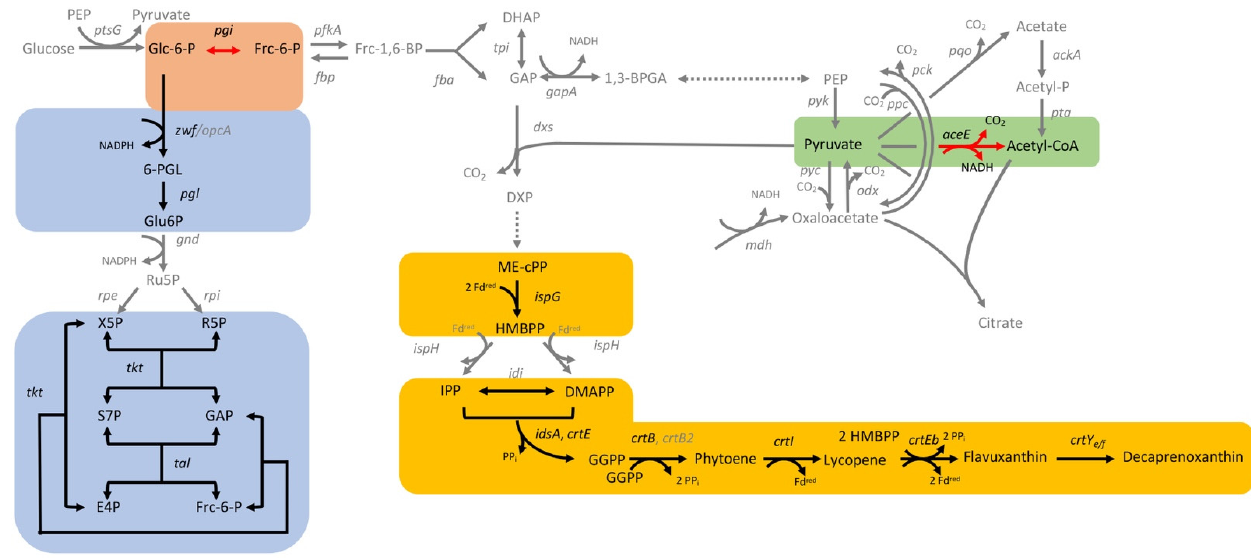
Figure 10. Scheme of C. glutamicum metabolism with CRISPRi target genes that significantly improved (red arrows) or reduced (black arrows) decaprenoxanthin biosynthesis in C. glutamicum when repressed. Grey is used to depict all other reactions in glycolysis (orange shading), the pentose phosphate pathway (blue shading), the TCA cycle (green shading), as well as the MEP pathway and the carotenogenesis (yellow shading). Abbreviations are explained in Figure 3.